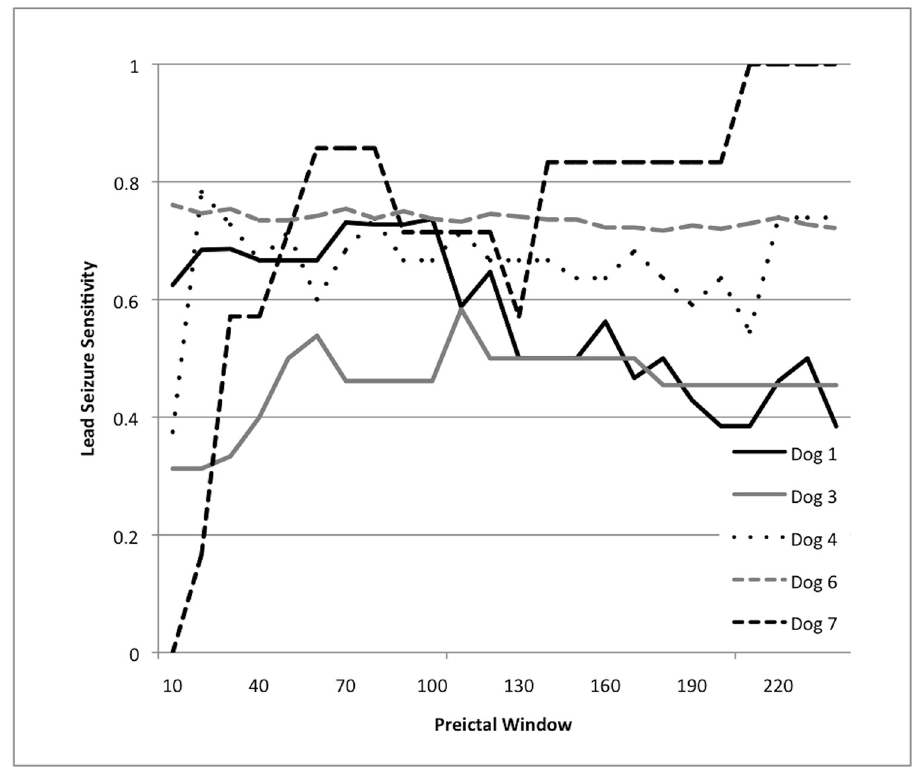
Fig 3. Performance of the SVM-correlation seizure prediction method varies with the choice of the preictal training window. The horizontal axis scales the preictal analysis window in minutes, and the vertical axis shows lead seizure sensitivity for the algorithm, if the algorithm threshold is tuned to maintain time in warning at 30%.